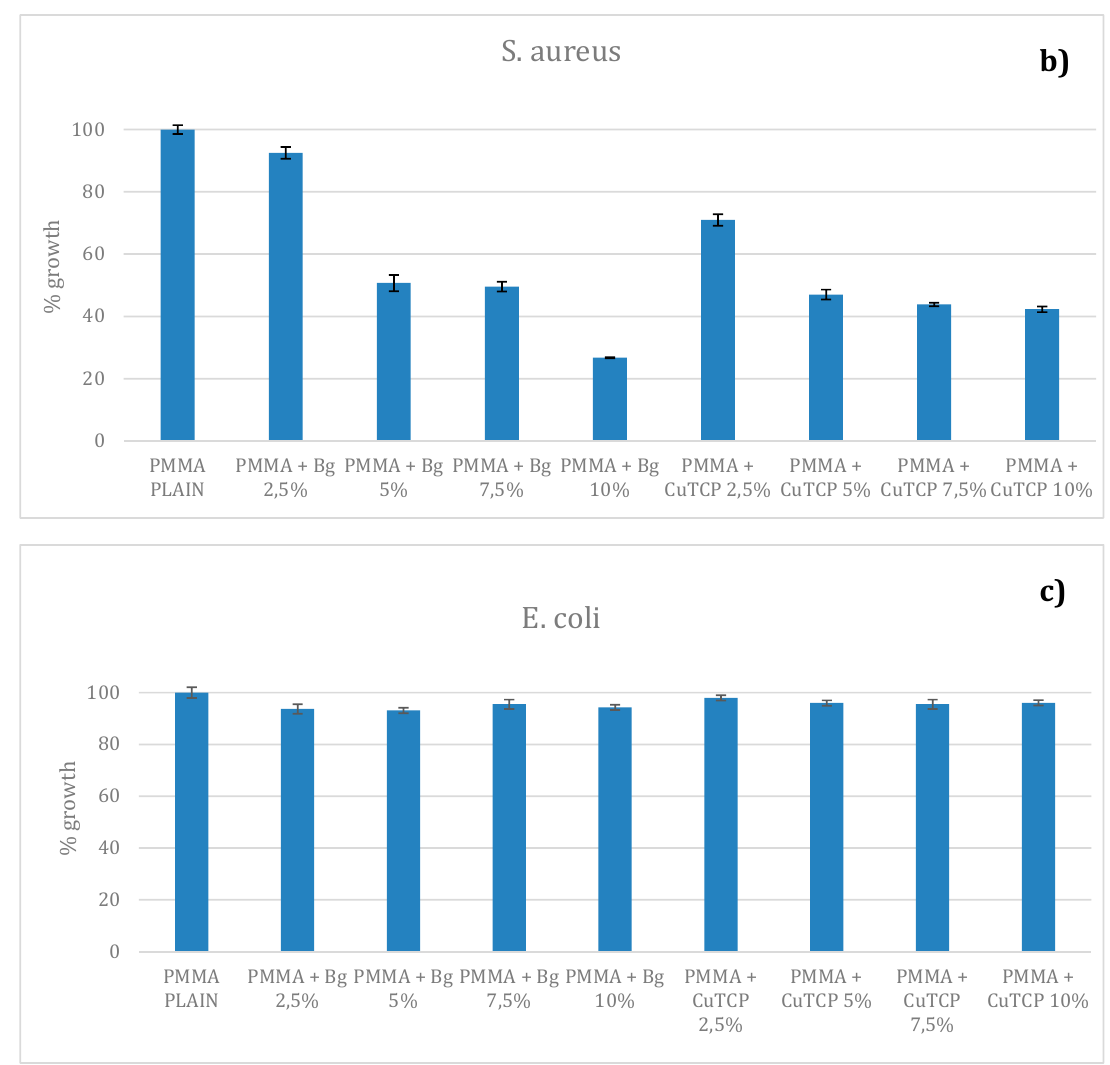
Figure 5. Antibacterial capability of PMMA, PMMA/BG, and PMMA/CuTCP composites. ( a ) P. aeruginosa growth; ( b ) S. aureus growth; ( c ) E. coli growth. Standard deviation and statistical analysis.